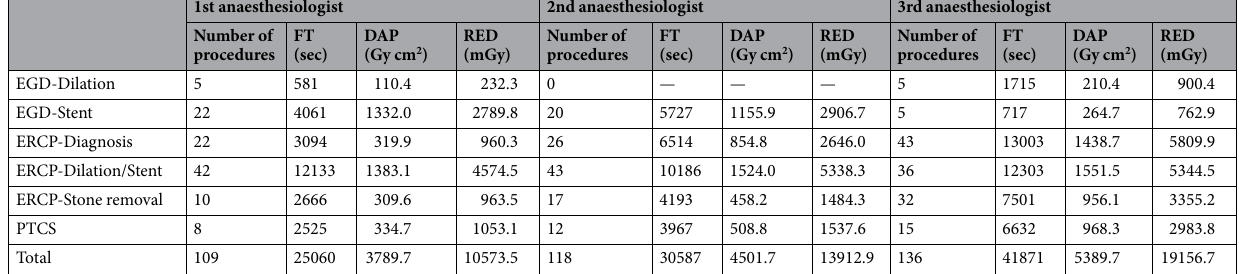
Table 3. Total radiation exposure per anaesthesiologist in the endoscopic retrograde cholangiopancreatography